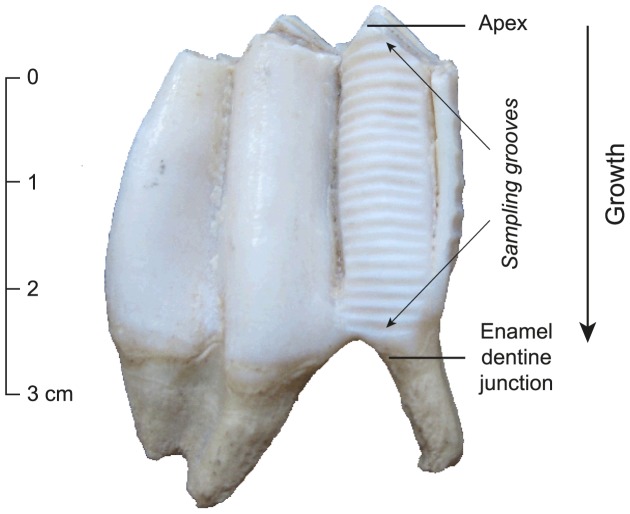
Sampling of molar enamel.Permanent M3 molar from specimen EBT2–1998 from El Brujo showing the series of enamel samples (grooves) that have been drilled along the highest lobe of the crown, from the apex to the enamel-root junction.